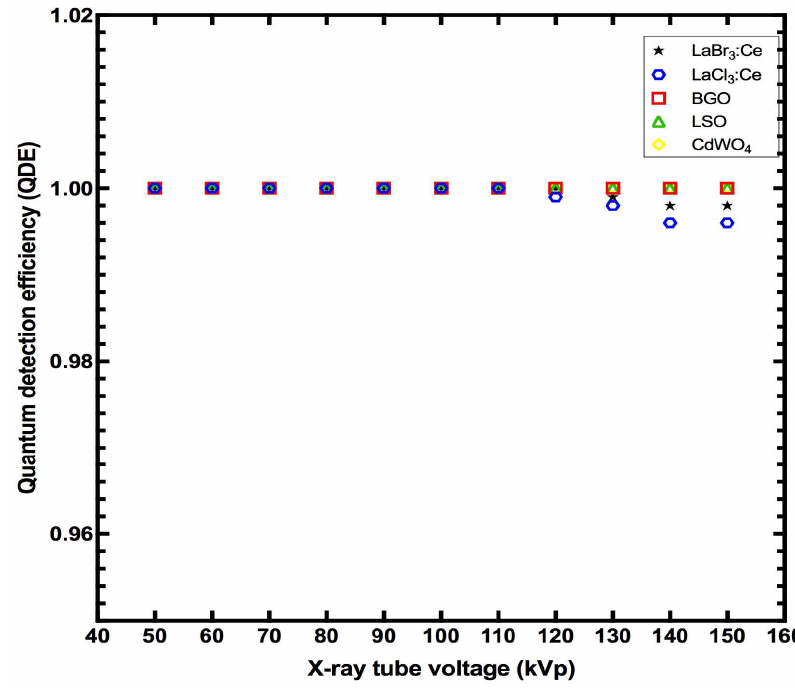
Figure 5. QDE of the LaBr 3 :Ce crystal in comparison with LaCl 3 :Ce, BGO, LSO and CdWO 4 crystals.